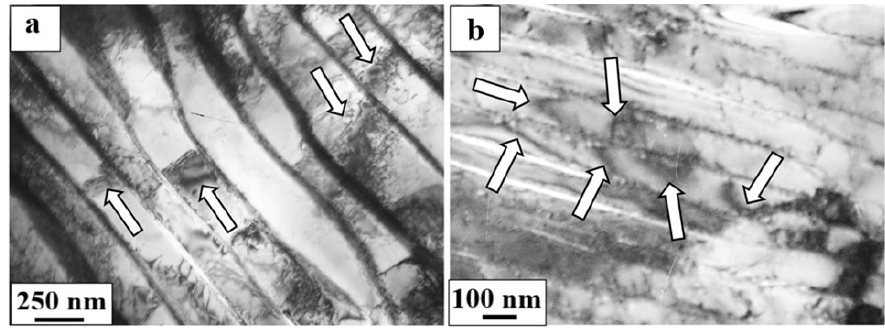
Figure 9. Electron microscopic images of extinction contours (indicated by